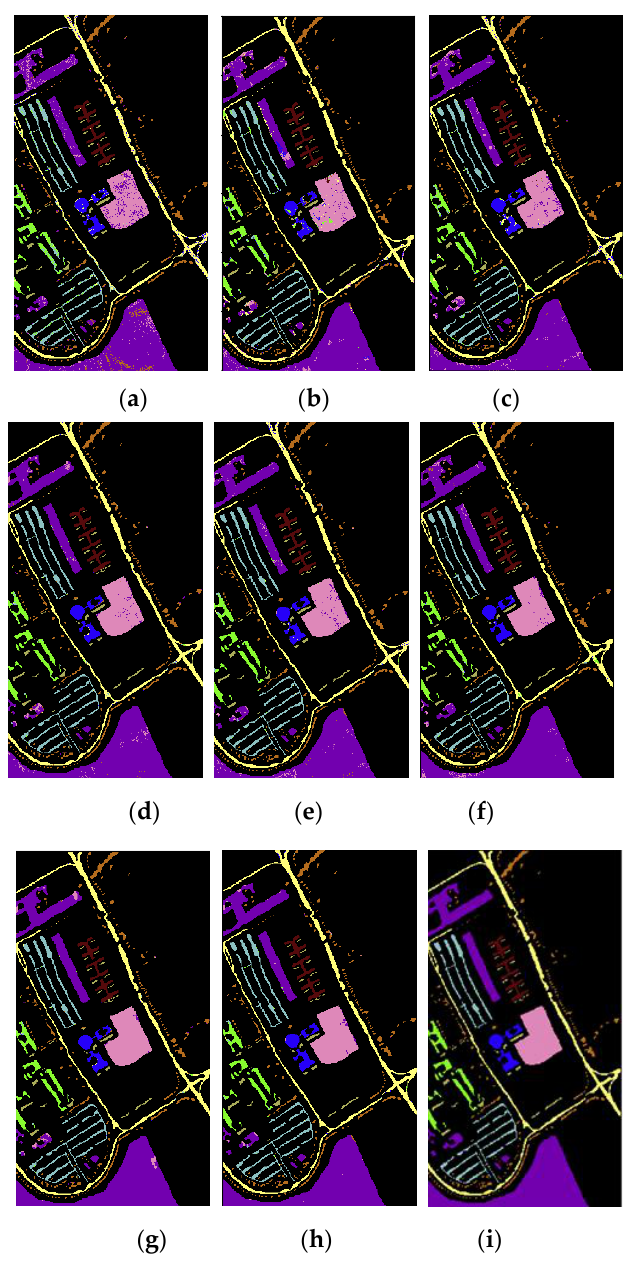
Figure 10a – i show the classification results of the SPE, PCA1, PCA1_SPE, PCA3, IM, IM_SPE, IM_DN, and IM_SPE_DN methods on the Pavia University data set, and Figure 10i is the ground truth of Pavia University dataset.